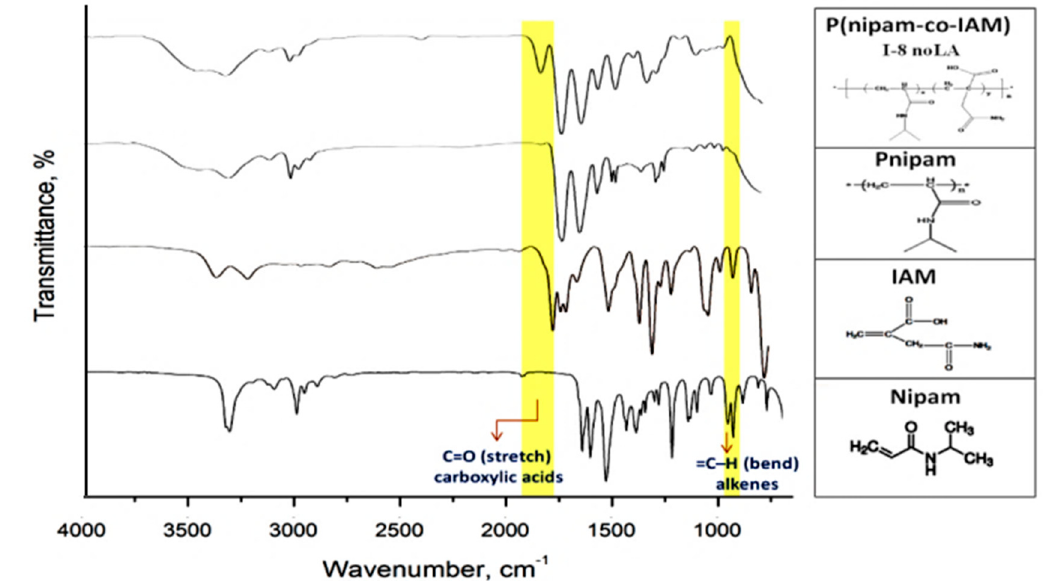
Figure 3. FTIR spectra of nipam, IAM monomers, atactic Pnipam (P-noLA) and P(nipam-co-IAM) (I-8 noLA).